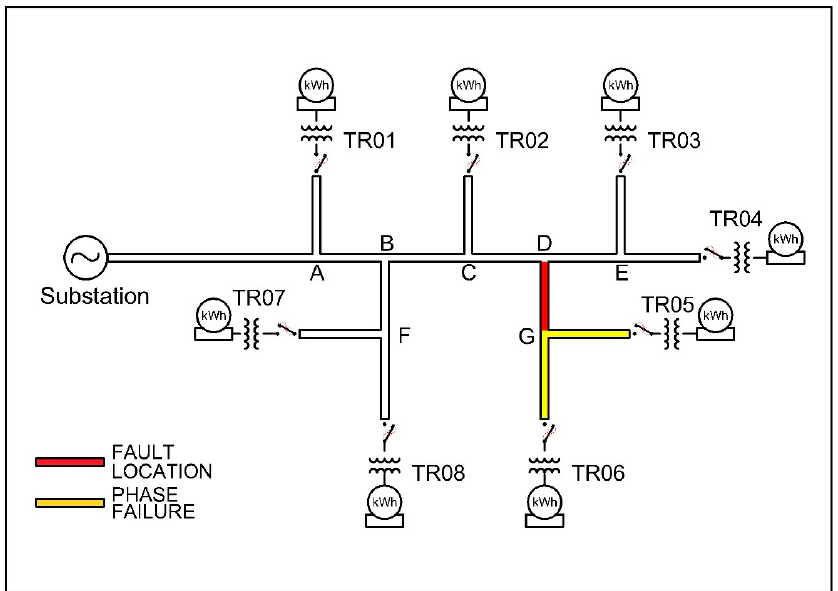
Figure 6. Faults on section DG.